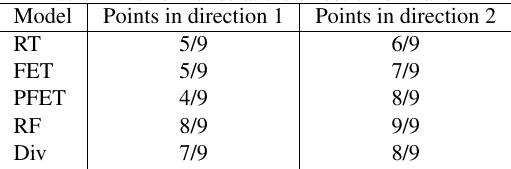
Table 2: Performance at the direction of 1 and 2